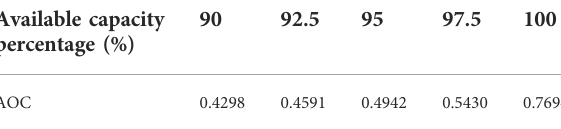
TABLE 6 AOC of wind power corresponding to key AOC in 2020.